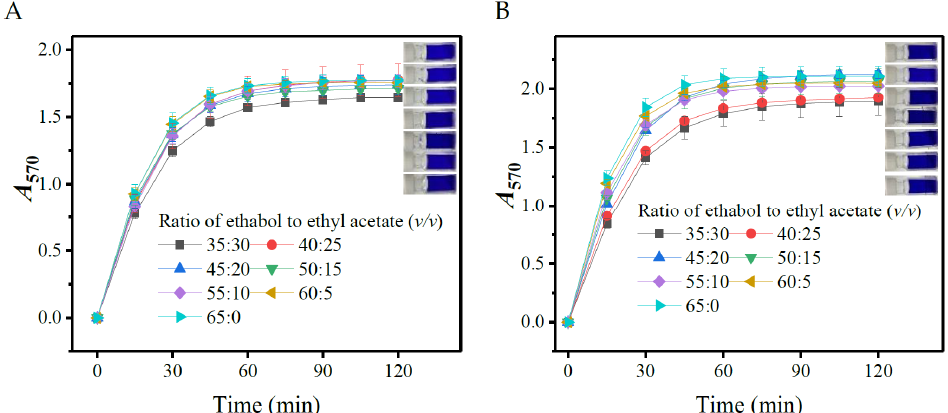
Figure 3. Effects of the ratio of ethanol to ethyl acetate on the color yield of gamma-aminobutyric acid ( A ) and L-glutamic acid ( B ). The rightmost part of each diagram shows the reacted mixtures with different ratios of ethanol to ethyl acetate (from top to bottom: 65:0, 60:5, 55:10, 50:15, 45:20, 40:25, and 35:30). A 570 : absorbance at 570 nm.